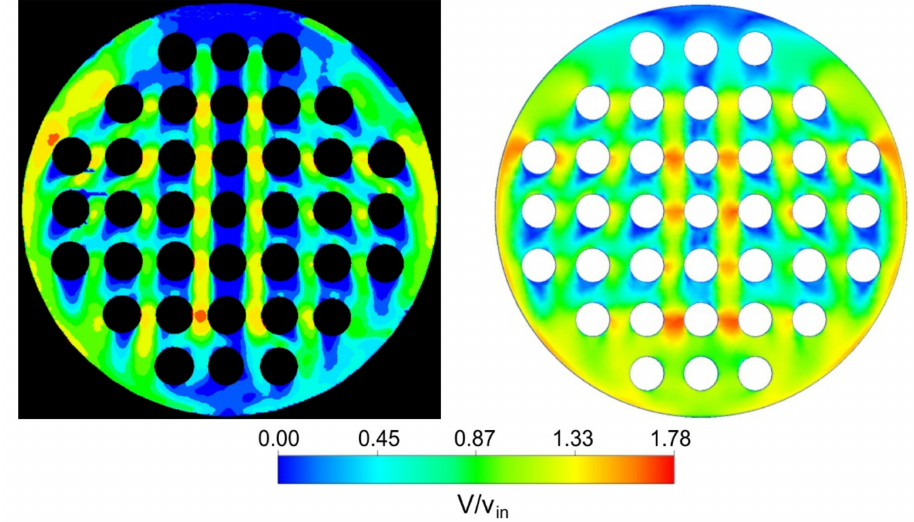
Figure 12. Comparison of scalar velocity fields V / v in for Q = 10 m 3 / h (CFD on the right, PIV on the